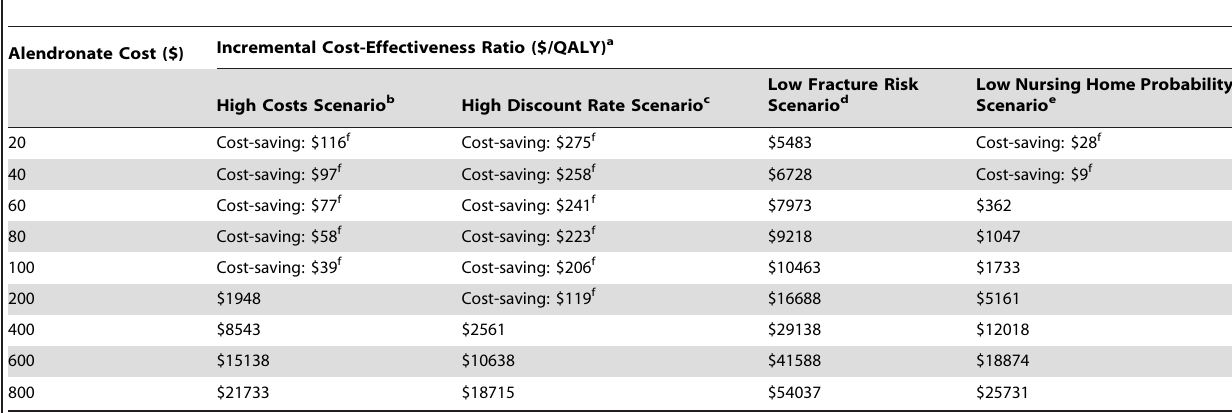
Table 2. Sensitivity Analysis Results; Costs, Discount Rate, Fracture Risk, Nursing Home Probability.